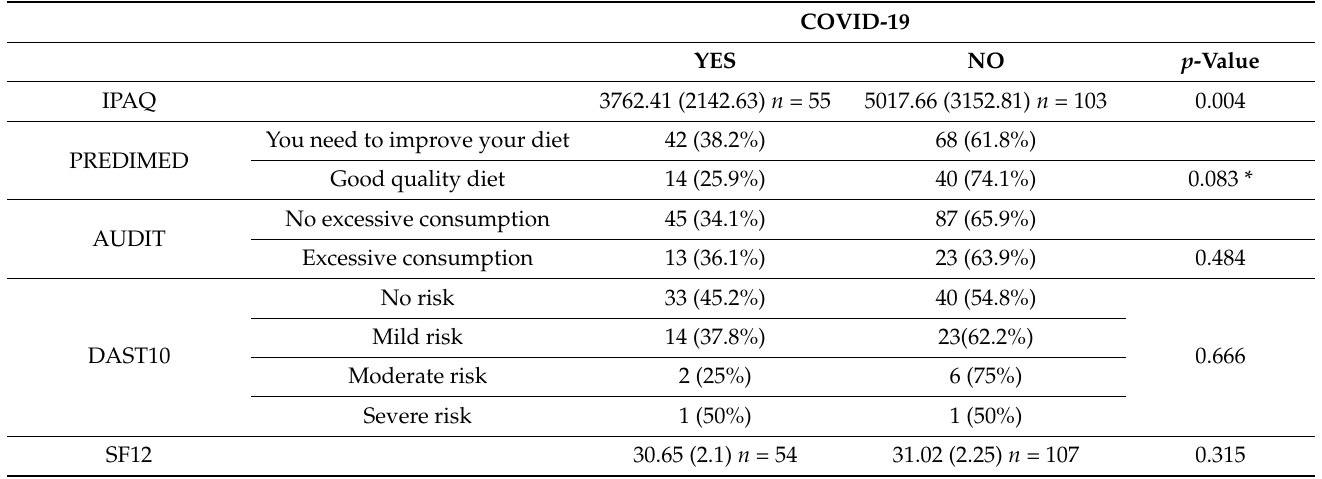
Table 2. Global scores of the IPAQ, PREDIMED, AUDIT, DAST, and SF12 questionnaires depending on the COVID-19